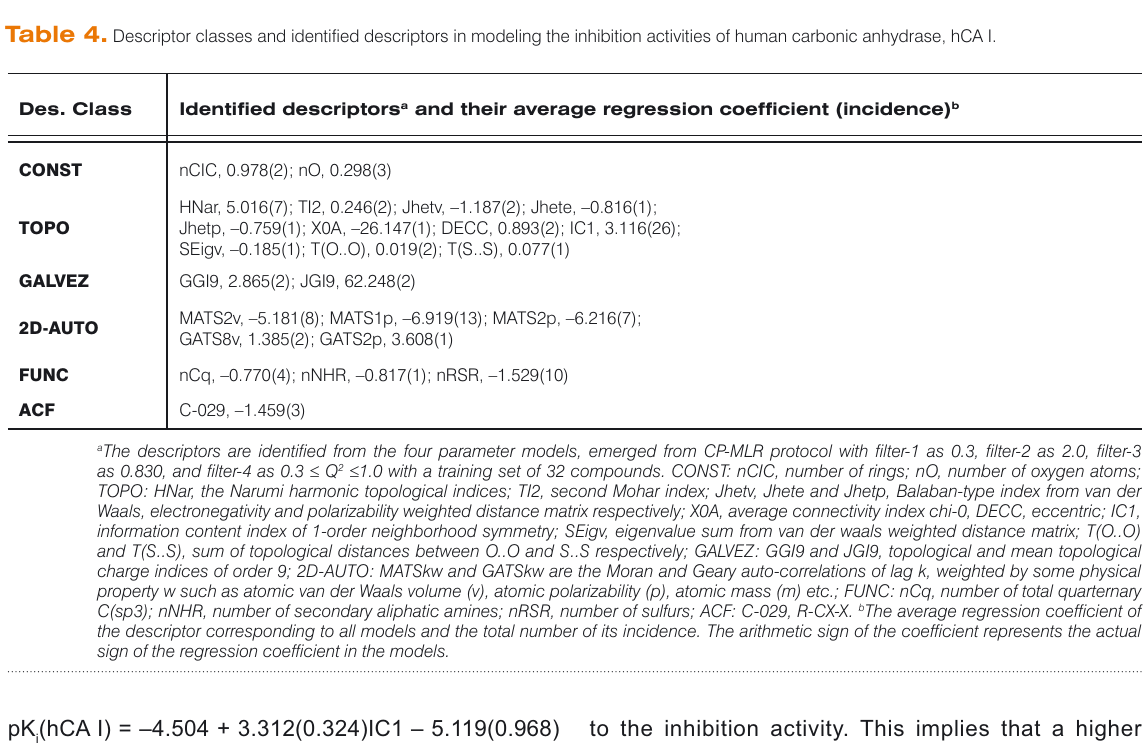
Table 4. Descriptor classes and identified descriptors in modeling the inhibition activities of human carbonic anhydrase, hCA I.